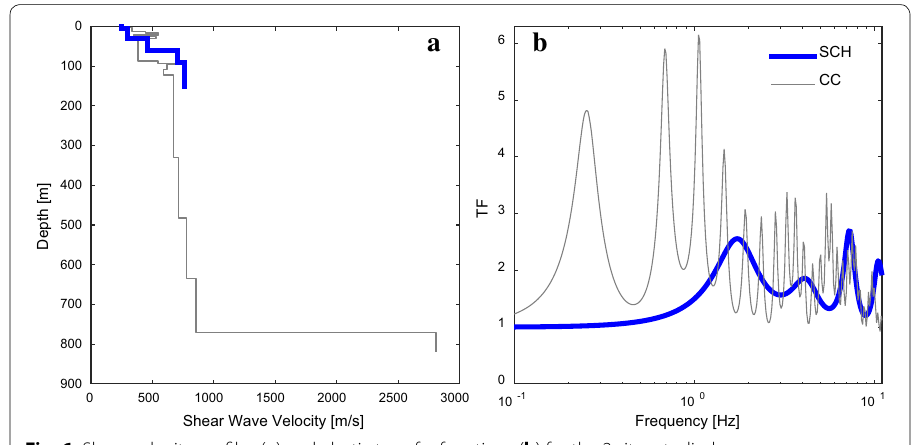
Fig. 6 Shear velocity profiles ( a ) and elastic transfer functions ( b ) for the 2 sites